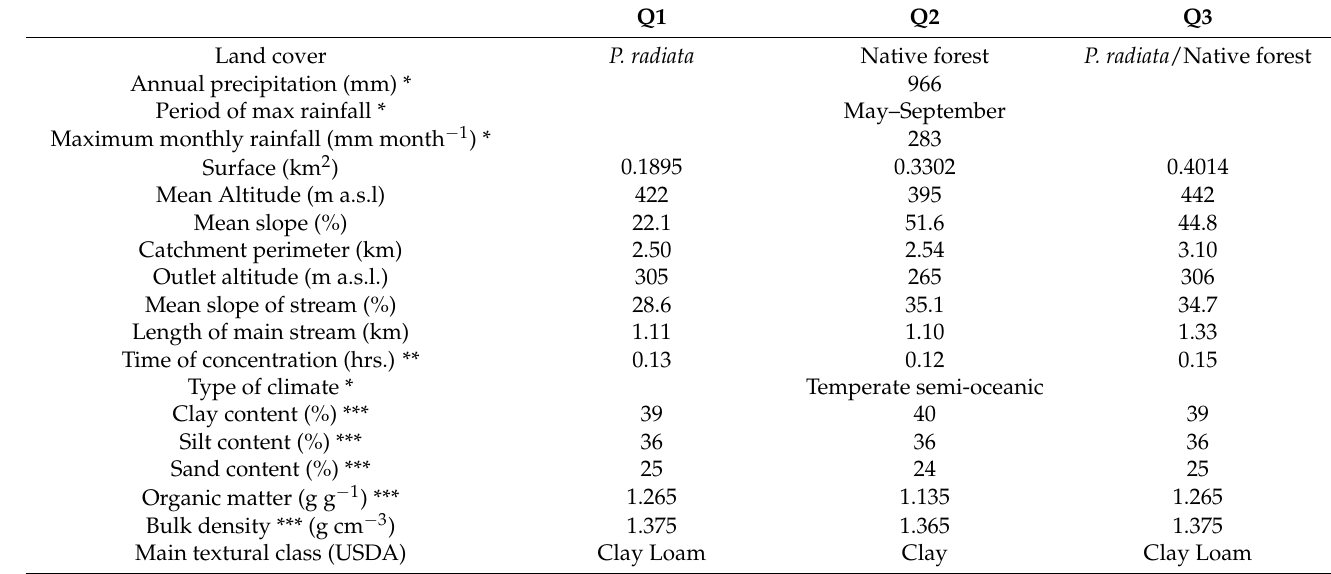
Table 1. Characteristics of three investigated catchments in Quivolgo, Constituci ó n,